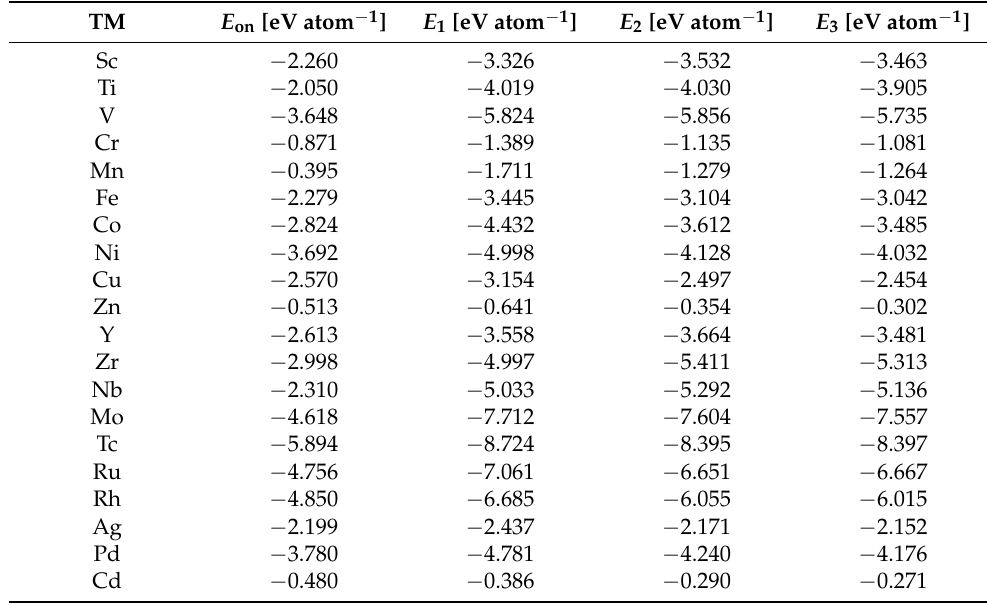
Figure 20. ( a ) A section schematic diagram of the TM@Mg core–shell structure and point-contact TM@Mg. Reproduced with permission [102]. Copyright 2014, Royal Society of Chemistry. ( b ) High- resolution transmission electron microscopy (HRTEM) of NbTiC–MgH 2 composite. ( c ) The optimized geometrical structures of MgH 2 adsorbed on (110) surfaces of NbTi, with Mg atoms in orange, H atoms in pink, Nb atoms in green, and Ti atoms in blue. ( b , c ) Reproduced with permission [32]. Copyright 2019, Royal Society of Chemistry. Table 6. The binding energy of substitution of TMs at the first, second, and third layer and on-surface adsorption (in eV) at Mg (0001) surface with the substituted Mg placed on the new surface. E on represents binding energy for TMs adsorption on the Mg surface; E 1 , E 2 , and E 3 represent TMs substituting one Mg atom from the first, second, and third layer, respectively. Reprinted/adapted with permission from Ref. [204]. Copyright 2014,